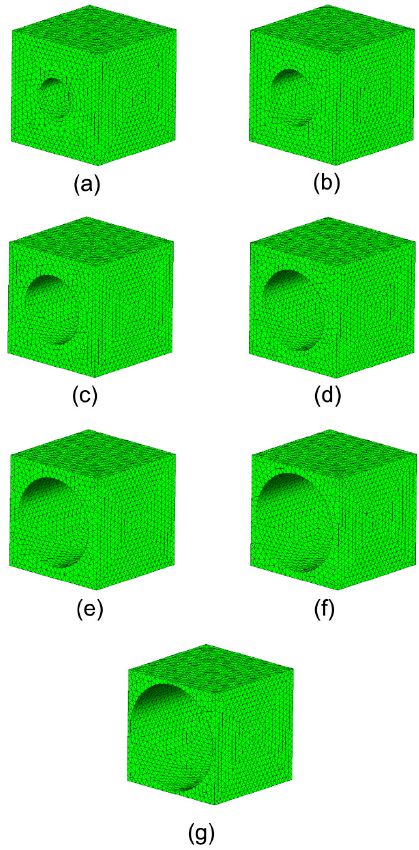
Figure 11. Mesh of solid cube with cylinder void inclusion for Darcy’s permeability homogenization. Void fractions ( a ) 0.1, ( b ) 0.2, ( c ) 0.3, ( d ) 0.4, ( e ) 0.5, ( f ) 0.6, ( g ) 0.7.